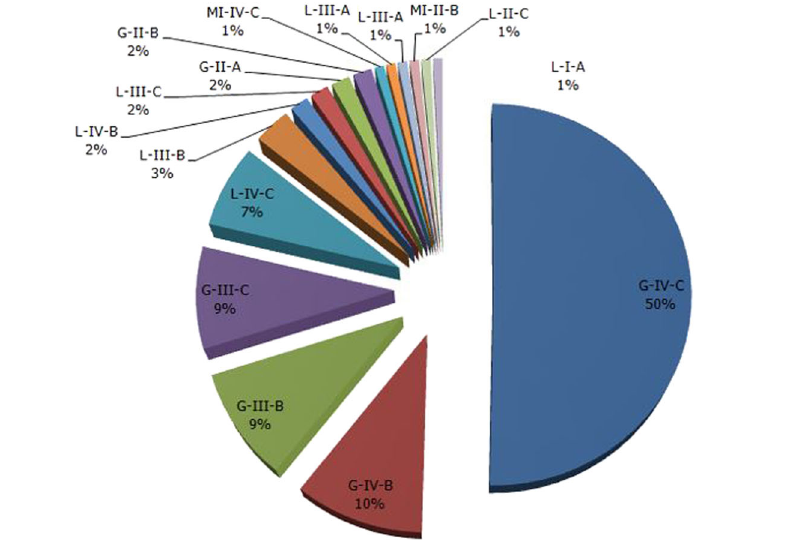
Fig. 5 Periodontitis distribution according to clinical forms. Showing generalised stade IV grade C periodontitis as the main clinical form encountered.